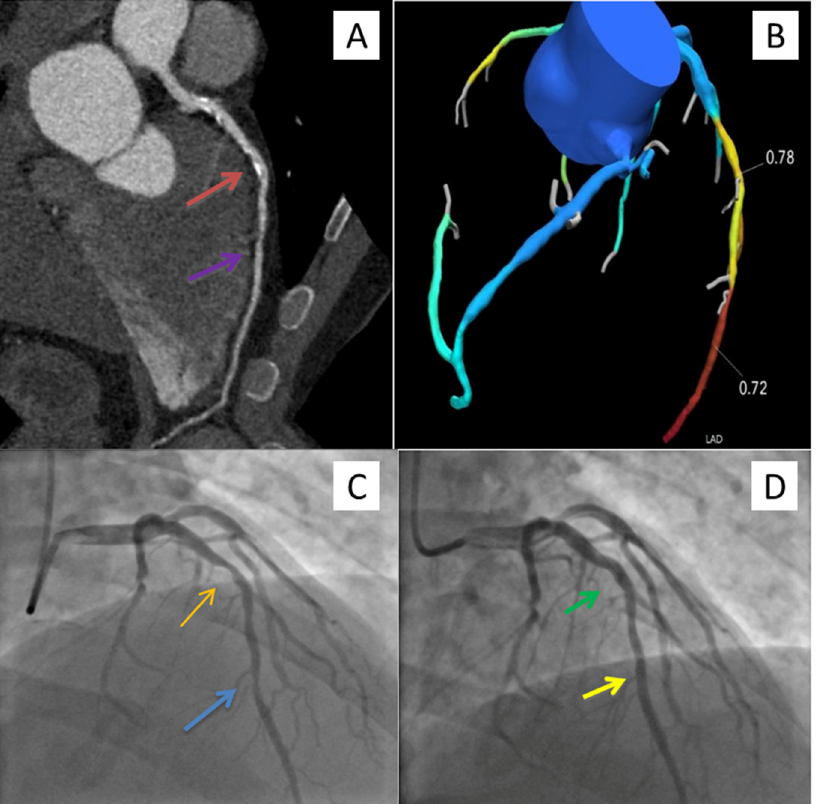
Figure 6. Study patient case. A 48-year-old male with hypertension, diabetes, dyspnea on exertion and atypical chest pain underwent coronary CTA. Multiplanar reformat of coronary CTA of the LAD ( A ), FFR CT ( B ), ICA pre- ( C ) and post- ( D ) PCI. LAD demonstrated a mid-calcified and non-calcified intermediate (50–70%) stenosis and a distal non-calcified intermediate (50–70%) stenosis (red and purple arrows), with evidence of lesion-specific ischemia. FFR CT values distal to the mid and distal LAD stenoses were 0.78 and 0.72, respectively. The patient underwent successful PCI (green and yellow arrows) of the mid and distal LAD stenoses (orange and blue arrows). FFR CT, fractional flow reserve derived from coronary computed tomography angiography (coronary CTA) datasets; ICA, invasive coronary angiogram; LAD, left anterior descending artery; PCI, percutaneous coronary intervention.